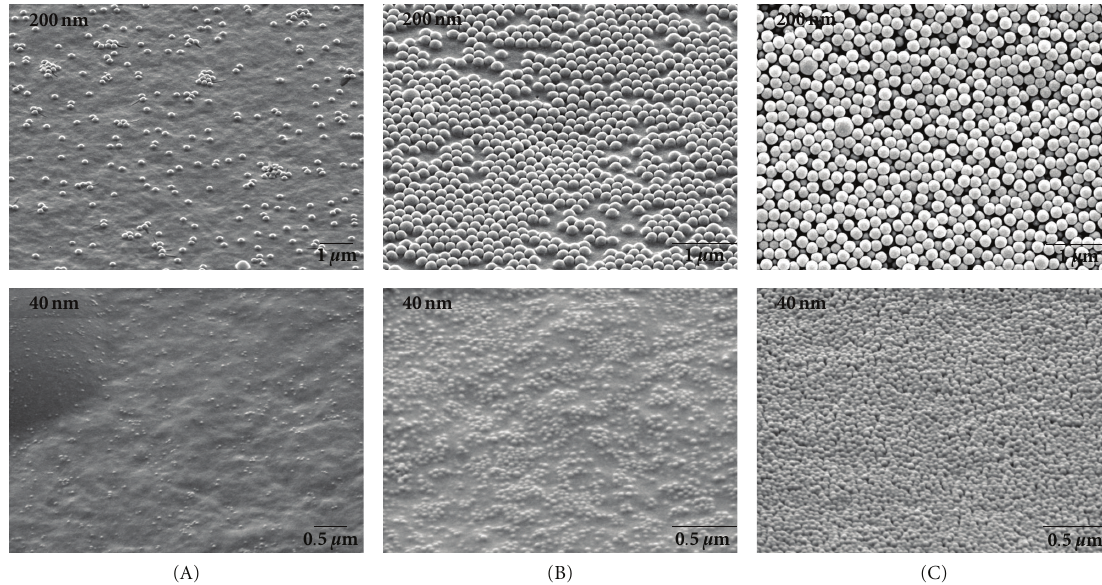
Figure 4: ESEM images of a microelectrode in each region (A), (B), and (C) after enzyme-NP assembly. Top row: microelectrodes after assembling 31 total alternating layers of 200 nm biotin NPs and streptavidin-AP. Bottom row: microelectrodes after assembling 21 layers of 40nm biotin NPs and streptavidin-AP.